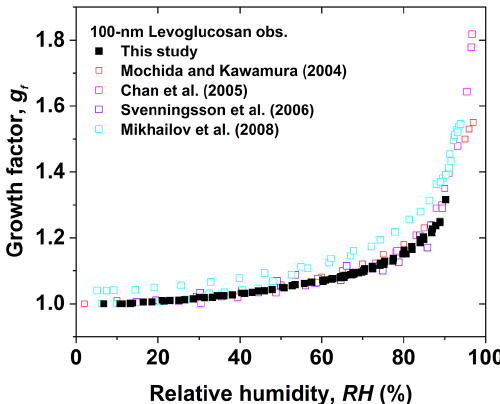
Figure 2. Concentration-dependent water activity ( a w ) of levoglu- cosan solution. The KD-derived a w (KD: Kreidenweis, cyan open square) is compared with observations (red open square), E-AIM (Extend Aerosol Inorganic Model, black line), and the a w model (SKT, blue line). The light grey shaded areas mark the subsaturated concentration with respect to bulk solution.